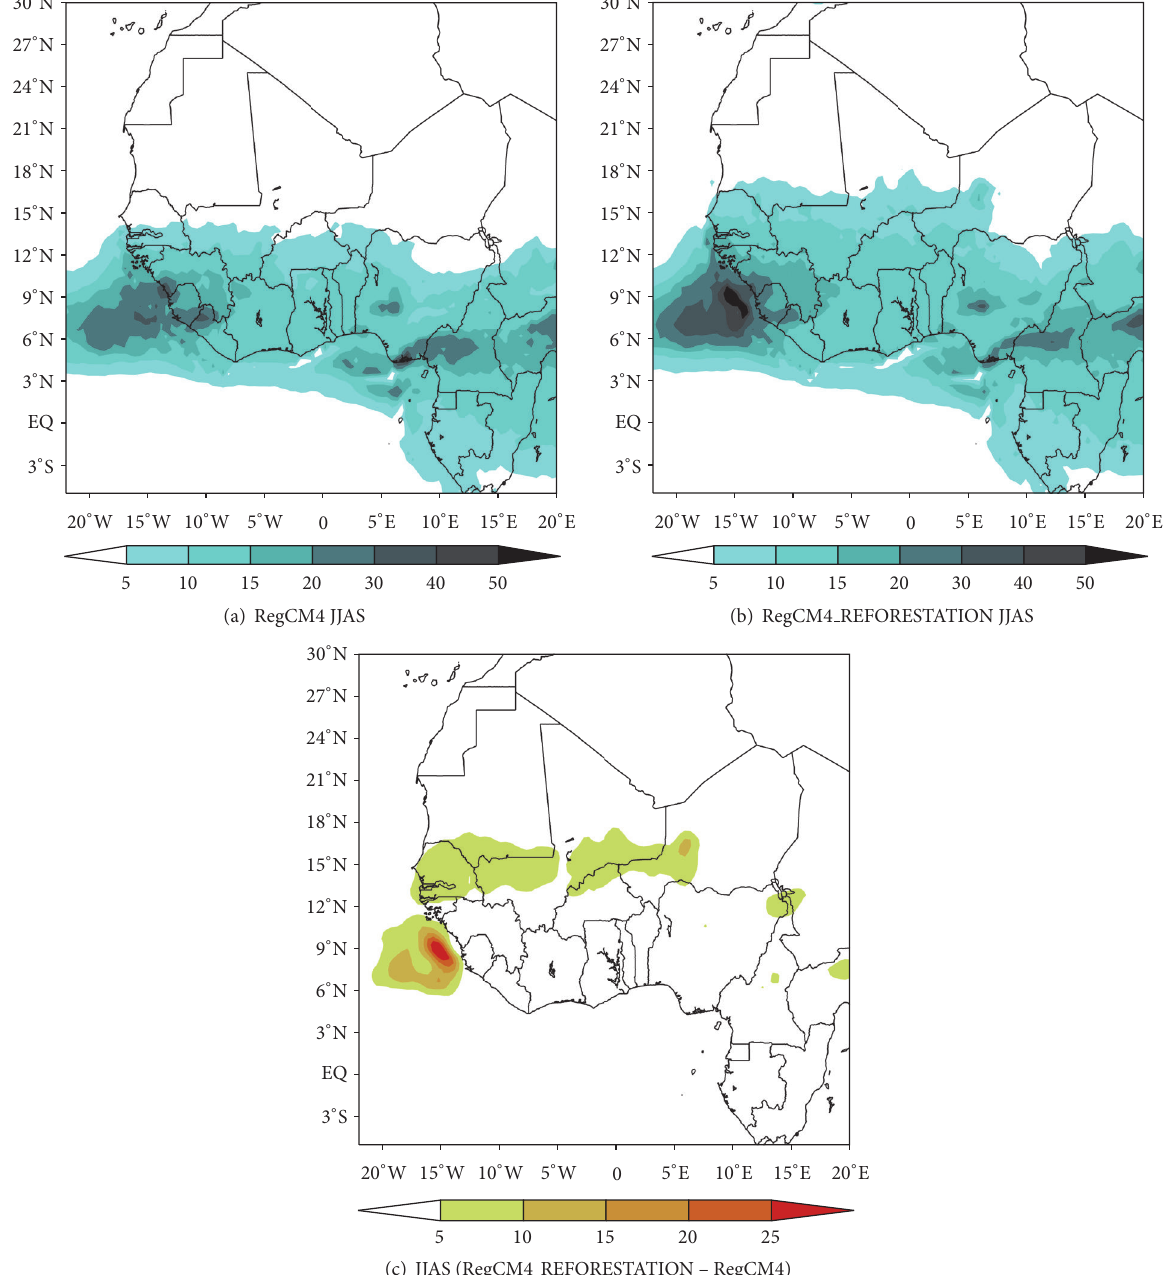
Figure 12: Mean JJAS 90th percentile of daily rainfall events (mm/day) over West Africa for both runs and their difference averaged from 2003 to